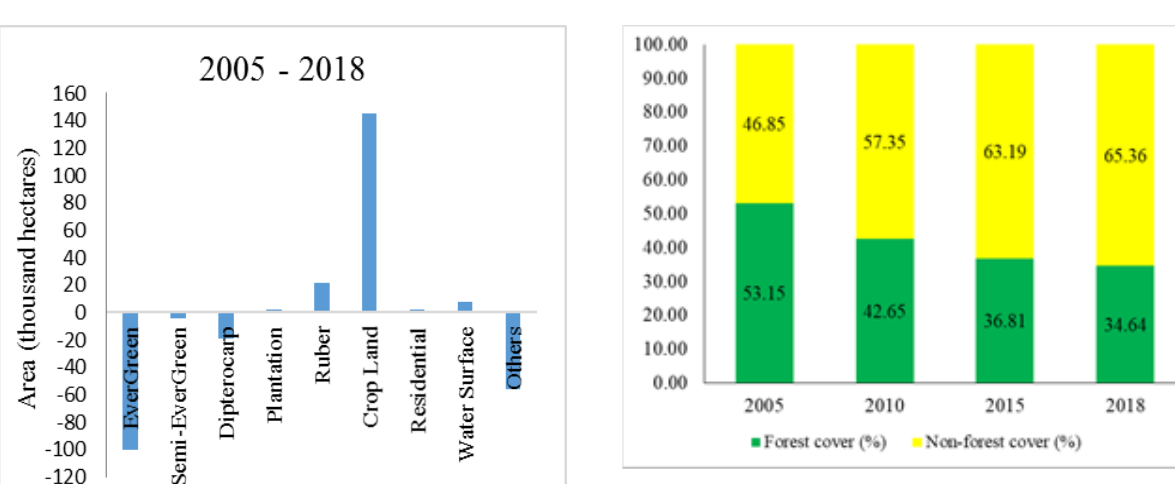
Figure 4. Changes in forest cover over time-period Figure 3. LULCC in period 2005-2018 Figure 4 indicates that over the period from 2005 to 2018, the region experienced a significant decrease in forest cover, while non-forest covers showed an upward trend of area. In particular, the percentage of forest cover in 2005 was 53,15%, with that figure for the year 2018 obtained by 34% which reduced